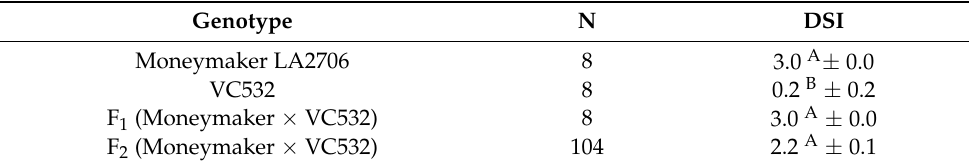
Table 2. Average ToBRFV disease severity index (DSI) of the tolerant genotype (VC532), the suscepti- ble genotype (Moneymaker), their F 1 hybrid and F 2 plants.